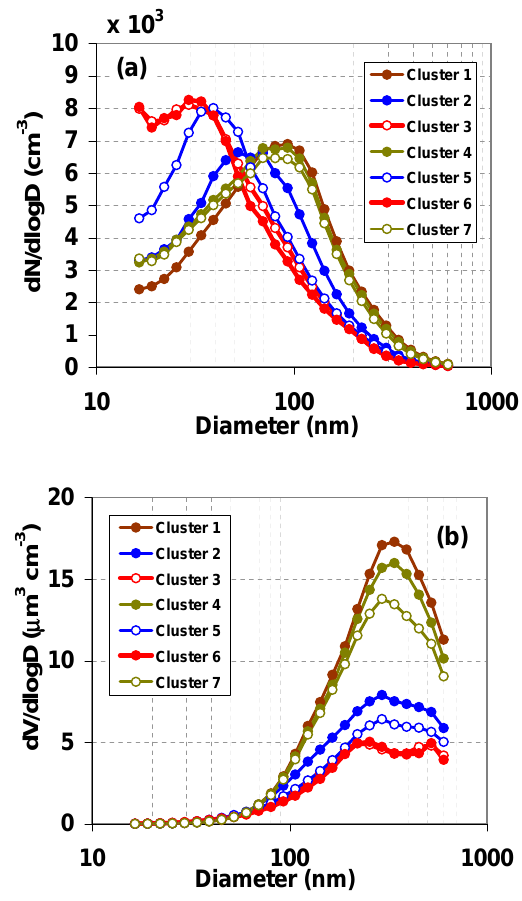
Fig. 10. Median (a) number and (b) volume size distributions per cluster. The colours are related to the flow pathway: Dust – brown (cluster 1), Maritime westerly – blue (clusters 2 and 5), Maritime north-westerly – red (clusters 3 and 6) and Continental – green (clusters 4 and